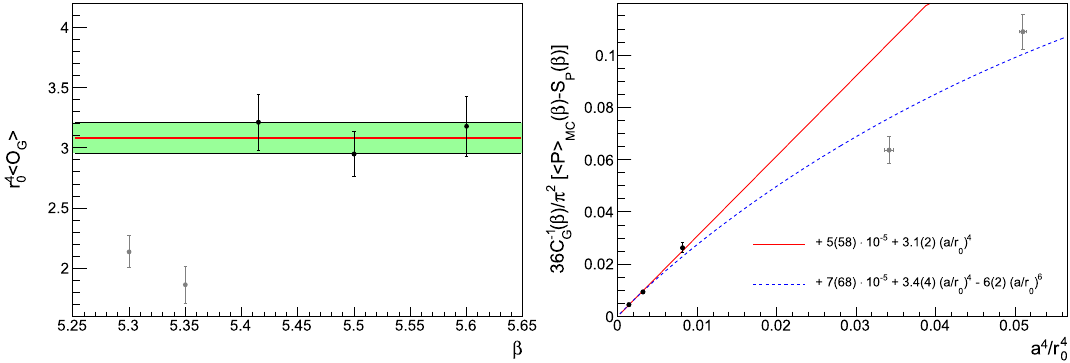
(solid red line, grey points are excluded), with possibly a a 6 correction (dashedblueline,greypointsareincluded).Bothpanelsreferto L =